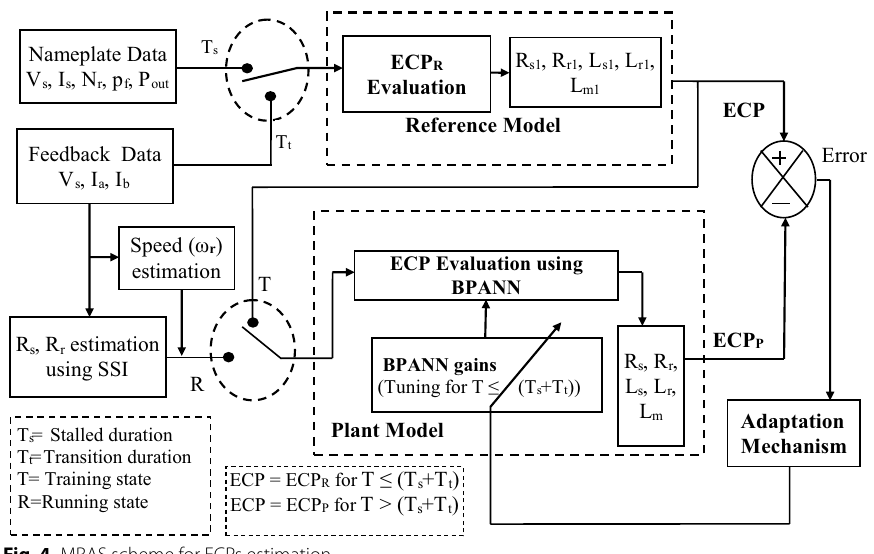
Fig. 4 MRAS scheme for ECPs